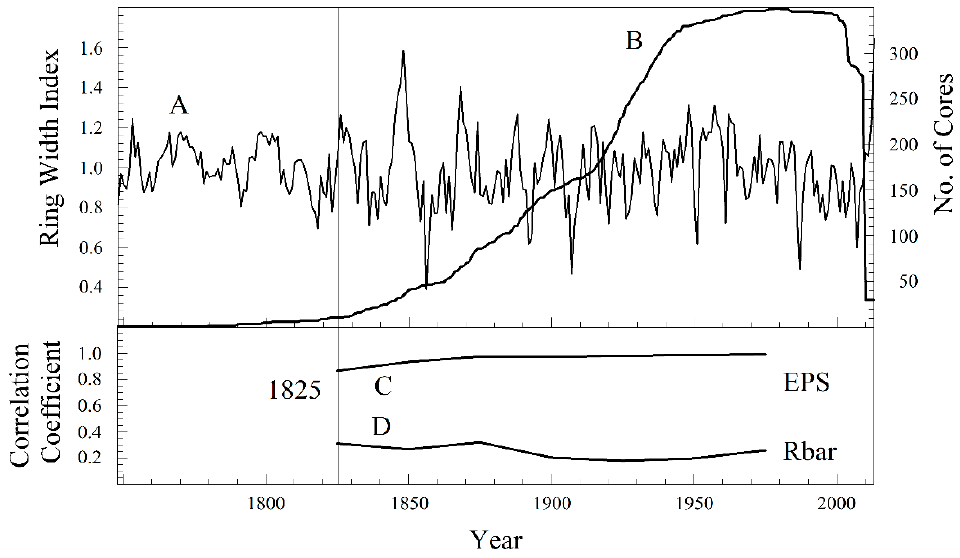
Figure 2. CW–DHM7 chronology. ( A ) standard (STD) chronology; ( B ) number of cores; ( C ) running expressed population signal (EPS); ( D ) Rbar statistics. Table 1. Statistical characteristics of the STD chronology of CW–DHM7.